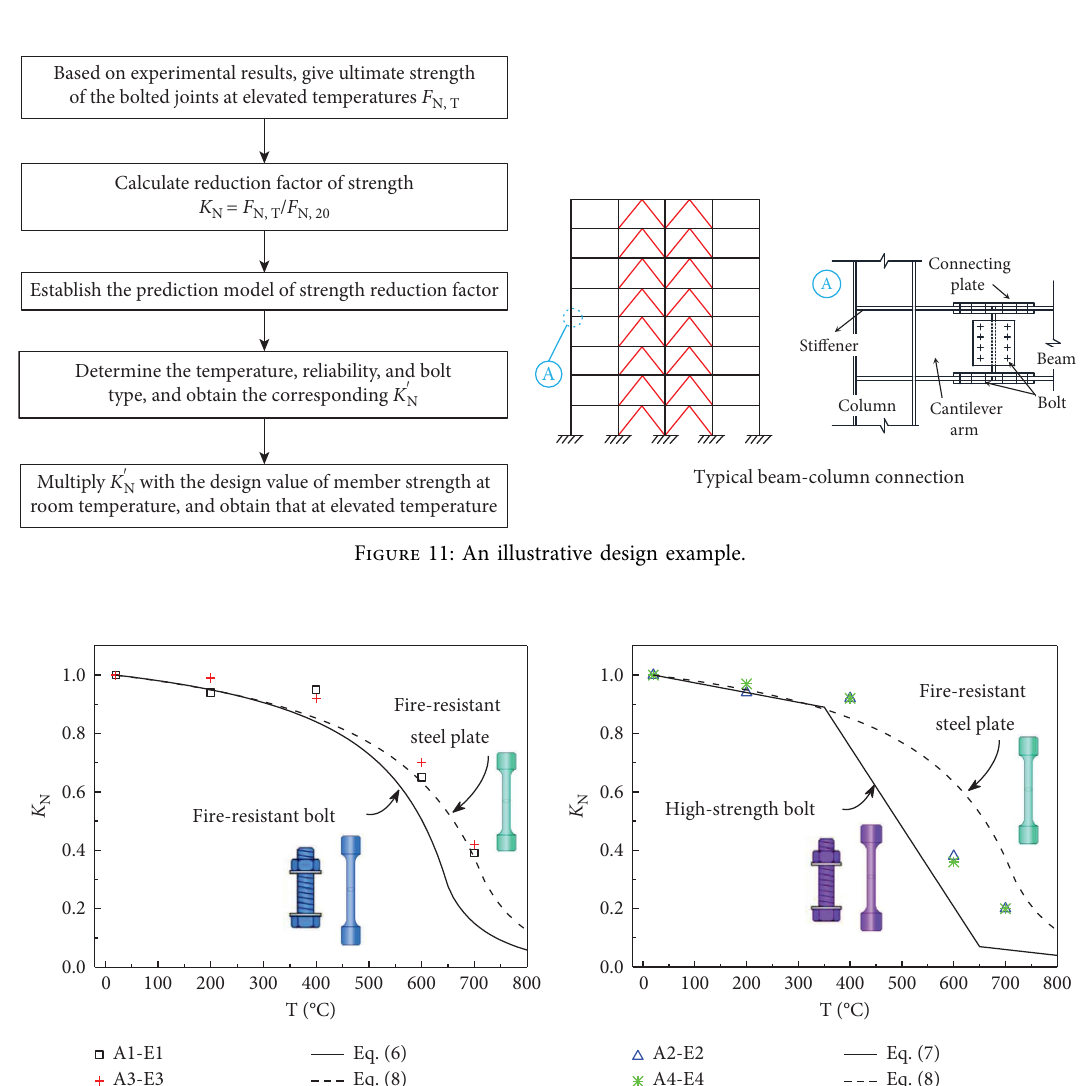
Figure 10: Comparison of experimental and calculated reduction factors of tensile strength.